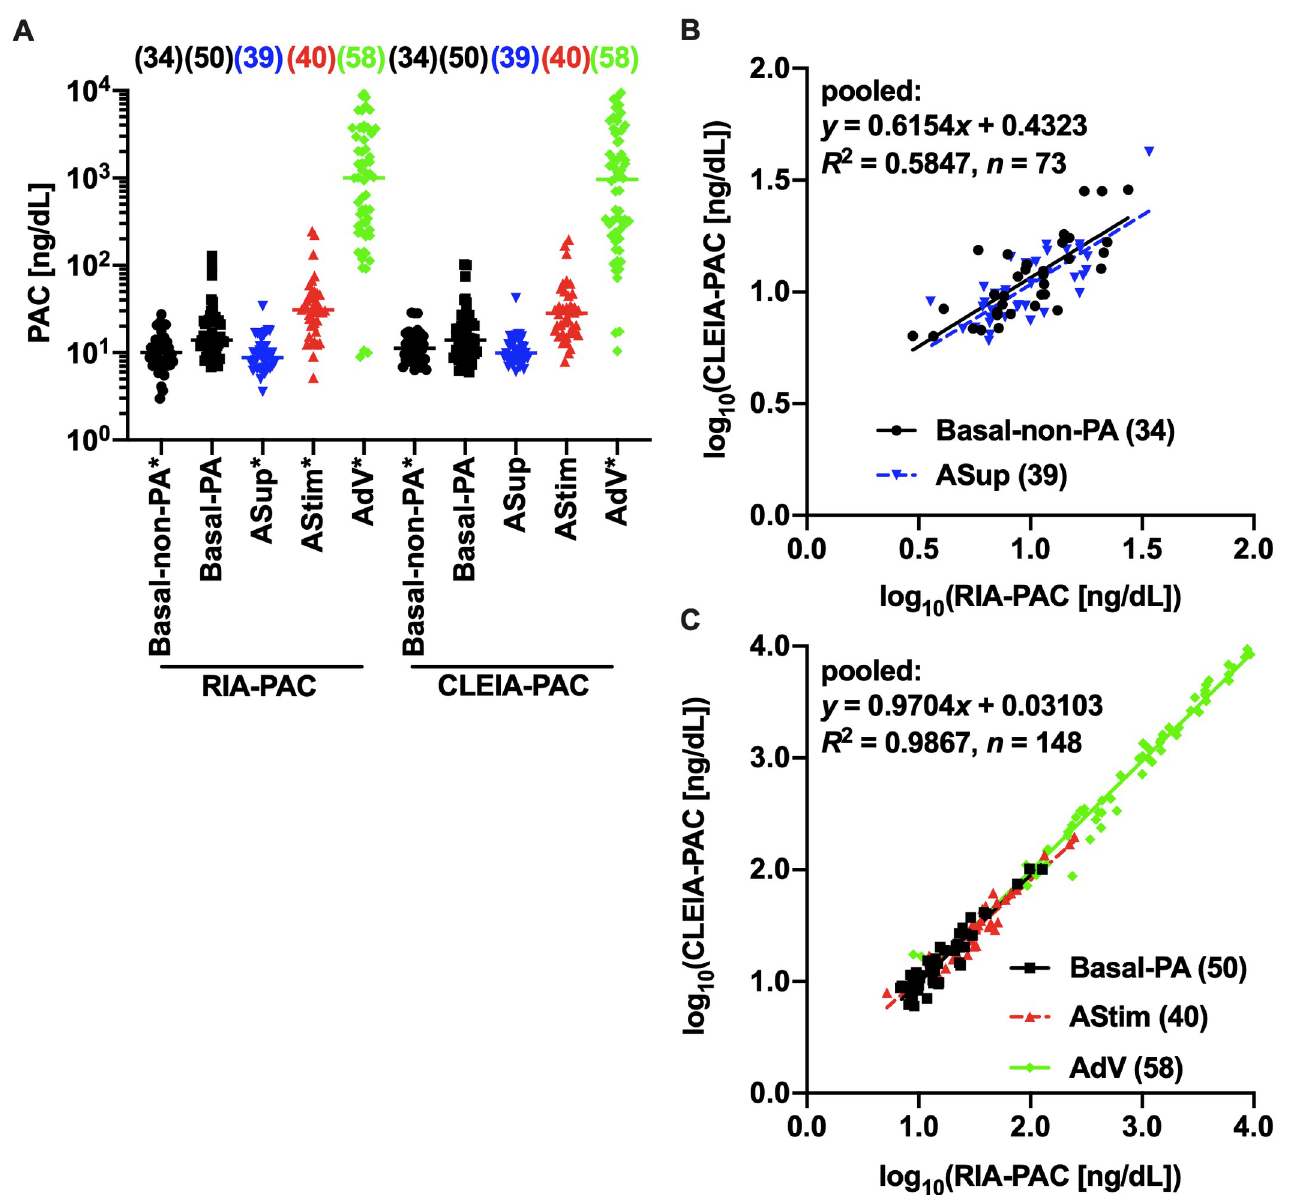
Fig 4. Distributions of RIA-PAC and CLEIA-PAC (CLEIA-PAC-final) values and relations between them in different sampling conditions. (A) The distributions of RIA-PAC and CLEIA-PAC values in the Basal-non-PA, Basal-PA, aldosterone suppression test (ASup), aldosterone stimulation test (AStim), and adrenal vein (AdV) groups. Groups, of which data are log-normally distributed, are indicated with � . For the other groups, the likelihood of log-normal distribution was much higher than that of normal distribution. Linear regression analyses between the log-transformed values of CLEIA-PAC and RIA-PAC in the complex A (the Basal-non-PA and ASup groups) (B) and in the complex B (the other groups) (C) are shown. The numbers of analyzed samples are shown in